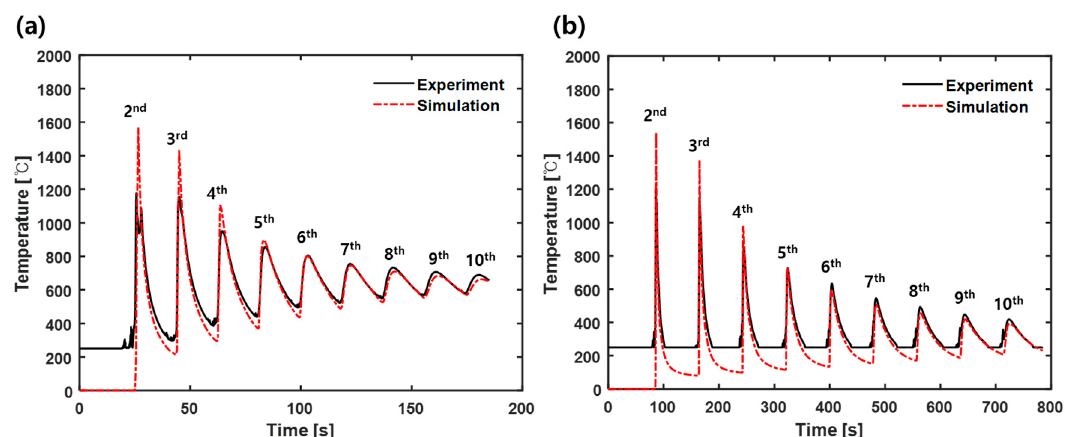
Figure 8. Comparison of the simulated and experimental results for the temperature history of 10- layer deposits at: ( a ) point ① under 0 s IPT and ( b ) point ① under 60 s IPT. layer deposits at: ( a ) point 1 (cid:79) under 0 s IPT and ( b ) point 1 (cid:79) under 60 s